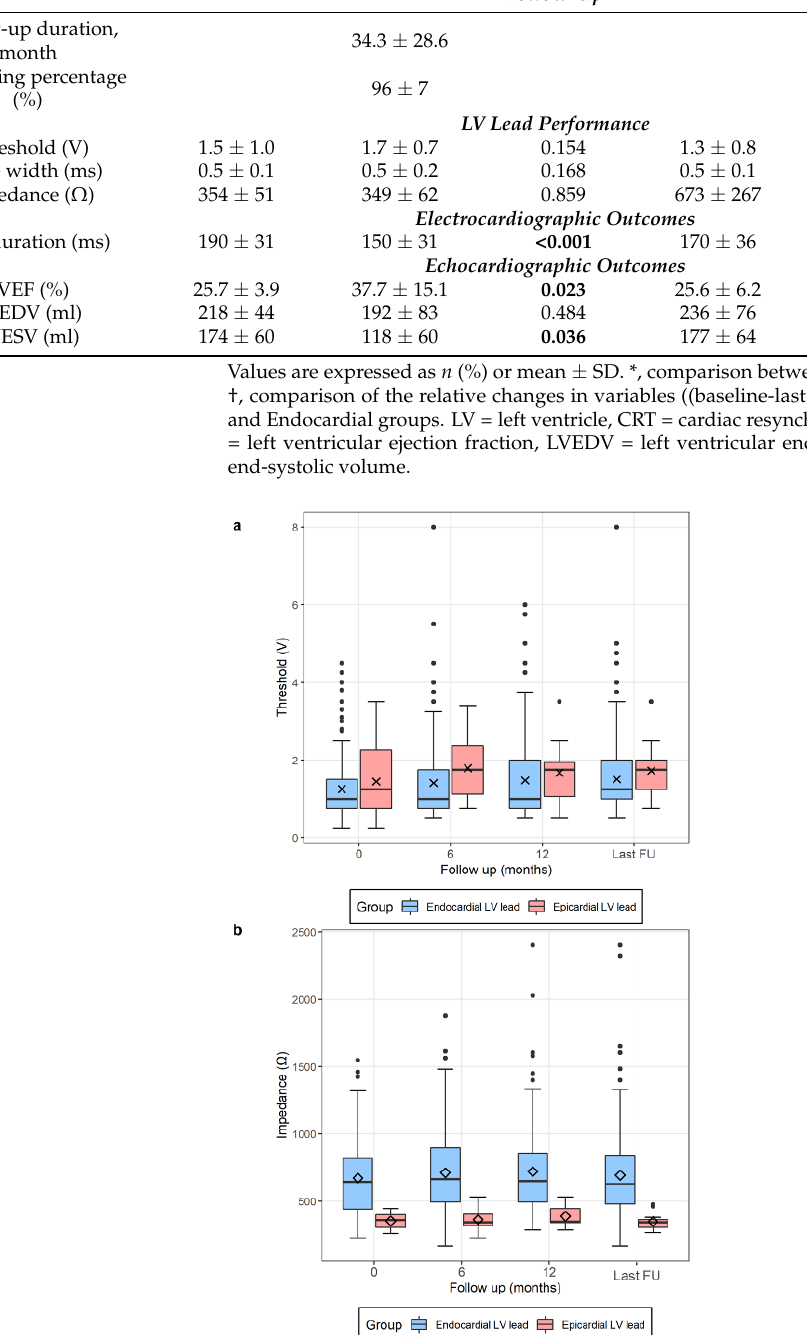
Endocardial LV Lead ( n = 243) p Value Last p Value * Follow-Up